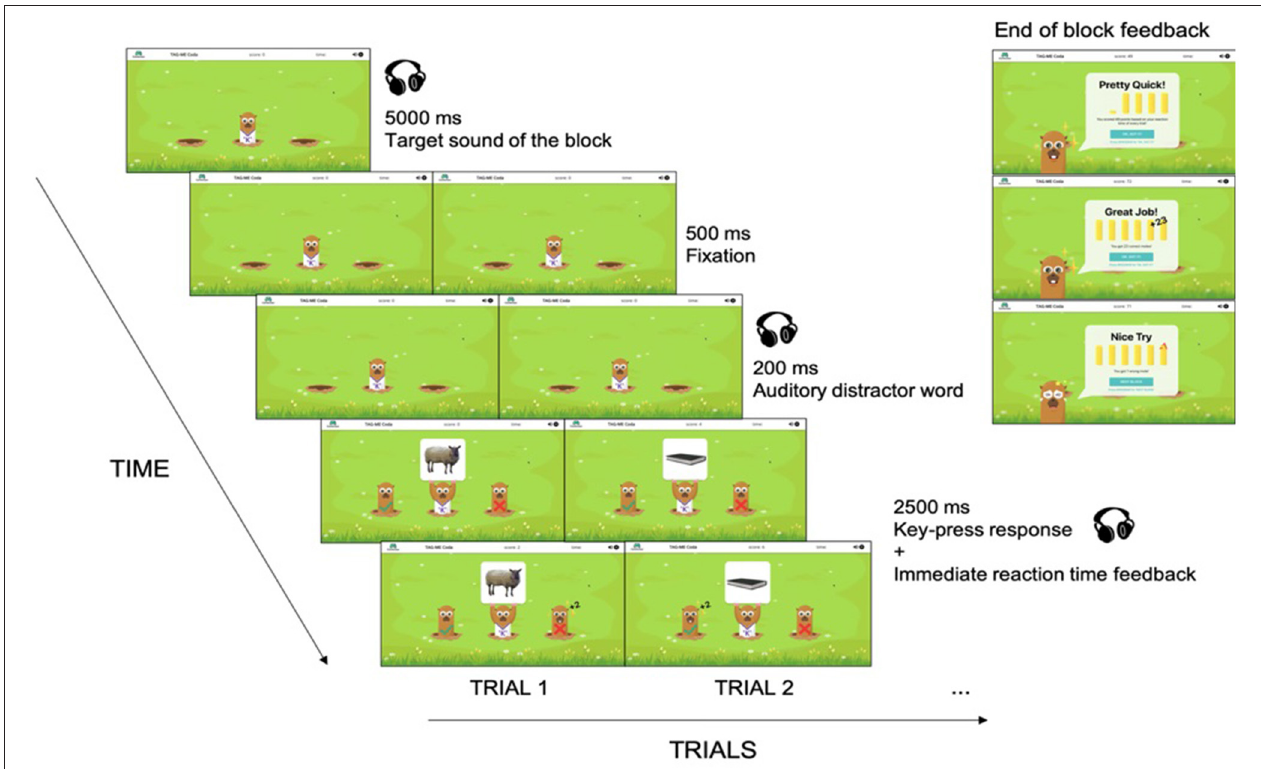
FIGURE 2 | TAG-ME Coda game design flow. The same design flow from the experiment was adapted into the game. A block began with the target sound shown visually and auditorily. Each trial started with a 500ms fixation on the middle mole, followed by an auditory distractor word played 200ms earlier than the picture onset. Reactions were made on whether the picture name ends in the target sound of the block by pressing the “J” or “K” key. Immediate feedback was given to each response by adding points according to how fast the participant responded, accompanied by a “ding” response sound confirming the participant’s button-press. Note that the game logic and timing was implemented to match the experimental task as closely as possible, but that the gamification features (i.e., animated cartoon figures, and coins that were earned based on performance) were added with the intention of making the task more enjoyable, and possibly motivating better